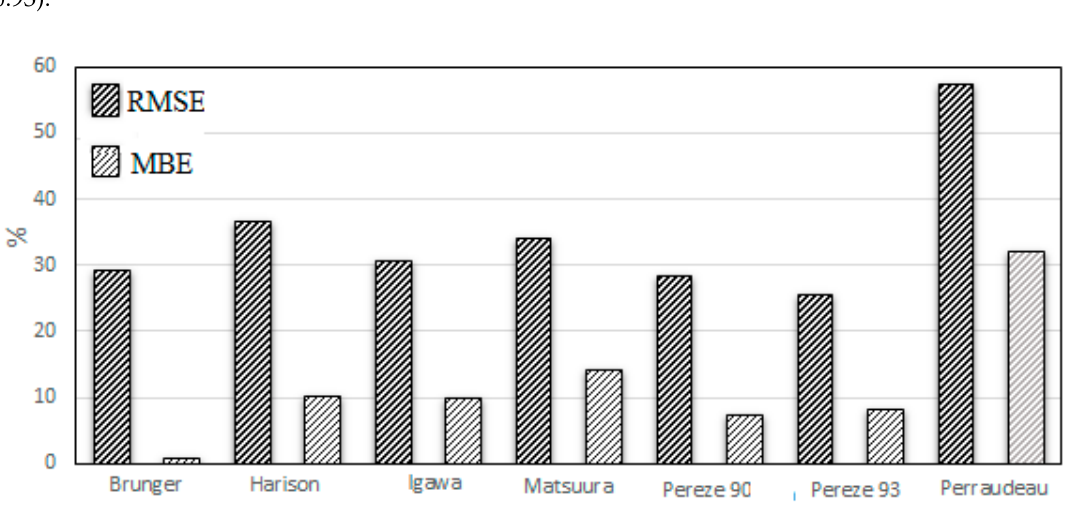
Figure 5. Root mean square errors (RMSE) and mean bias errors (MBE) for the investigated models